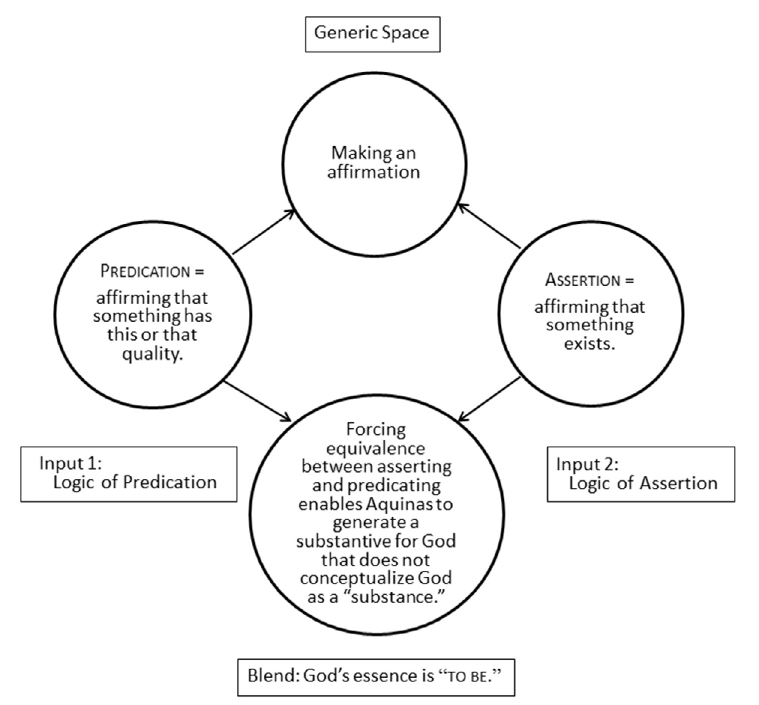
Figure 5. Cognitive mapping of Aquinas’s blend: god’s essence is “to